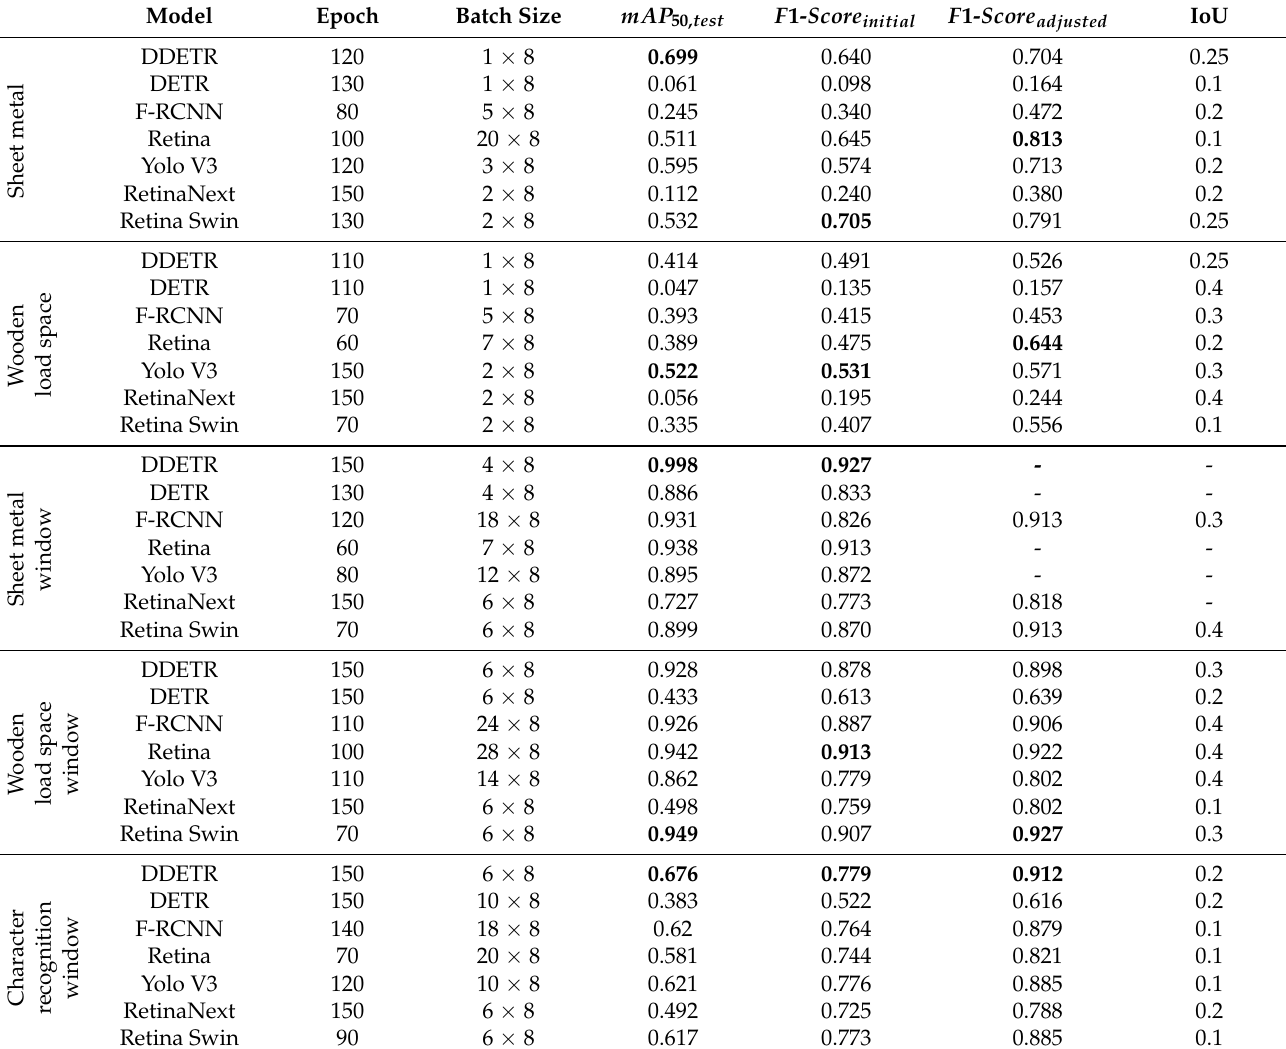
Table 3. Model performances; bold numbers highlight the best performance for each use